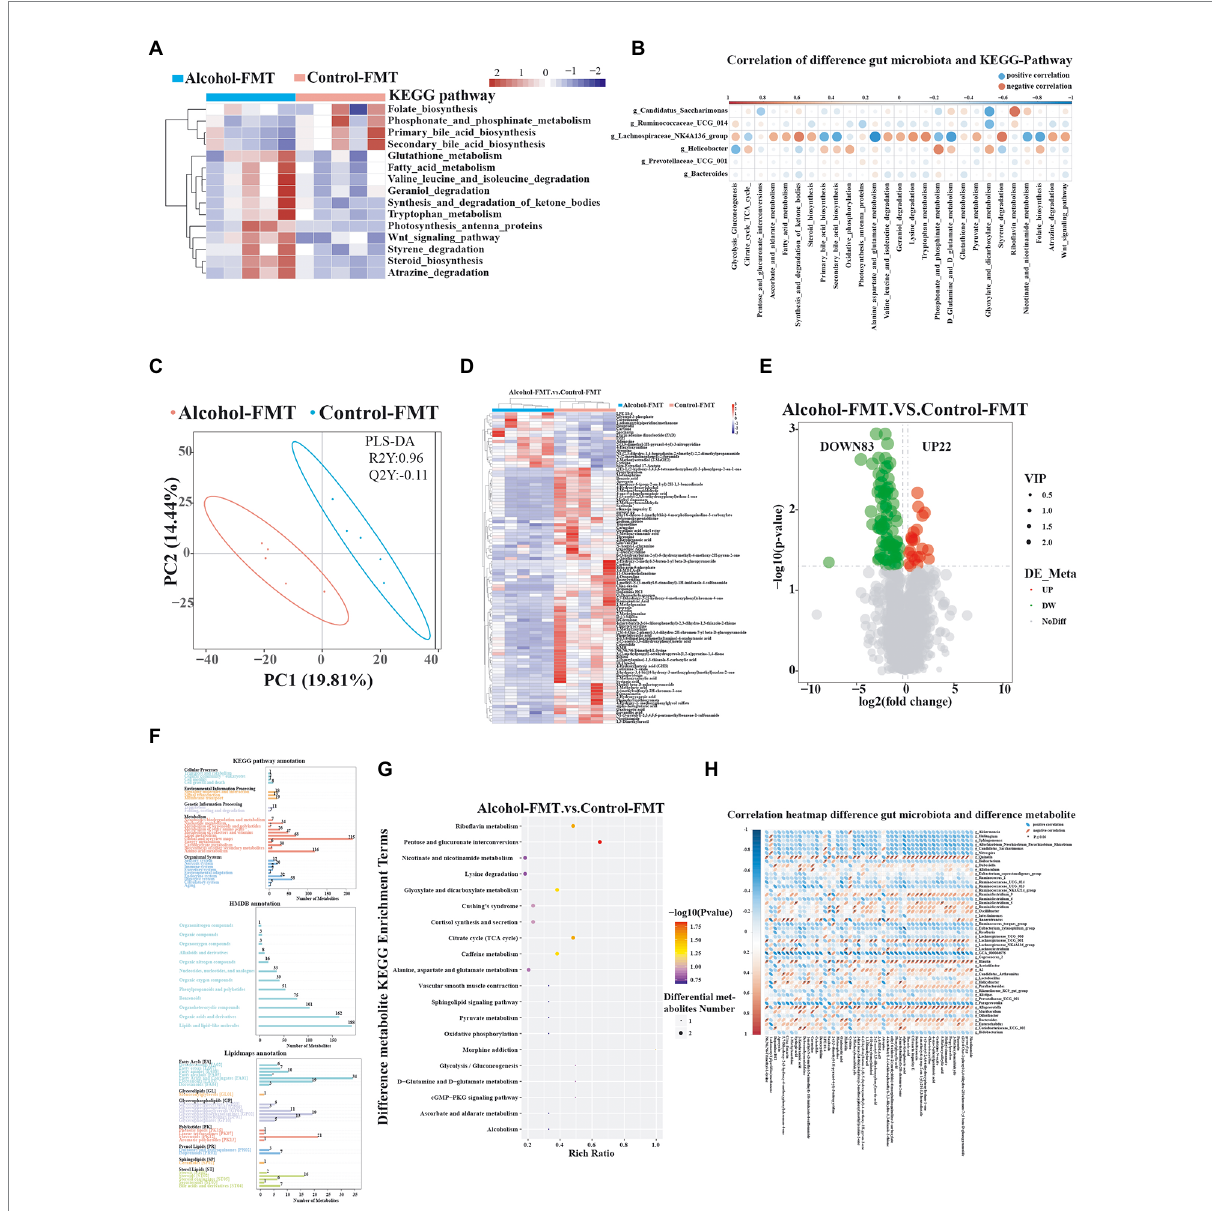
FIGURE 4 The alteration in the gut microbiota of the alcohol-FMT group was closely associated with differences in intestinal metabolites. (A) KEGG pathway analysis (top 15 different pathways). (B) Correlation map of differentially enriched KEGG pathways and differentially abundant bacteria. (C) PLS-DA score plot discriminating the intestine digesta metabolome from the control-FMT and alcohol-FMT groups. (D) Heatmaps of the differentially altered metabolites. (E) Volcano plot showing the changes in the intestine digesta metabolome (log2 fold change ≥ 1.5). (F) Metabolite pathways annotated for all metabolites based on the KEGG database, HMDB, and LIPID MAPS database. (G) KEGG pathway enrichment bubble diagram of differentially altered metabolites. (H) Correlation heatmap of differentially abundant gut microbiota and differentially altered metabolites from the alcohol-FMT and control-FMT groups. Blue represents a positive correlation, red represents a negative correlation, and a darker color corresponds to a stronger correlation. * p < 0.05 and ** p <